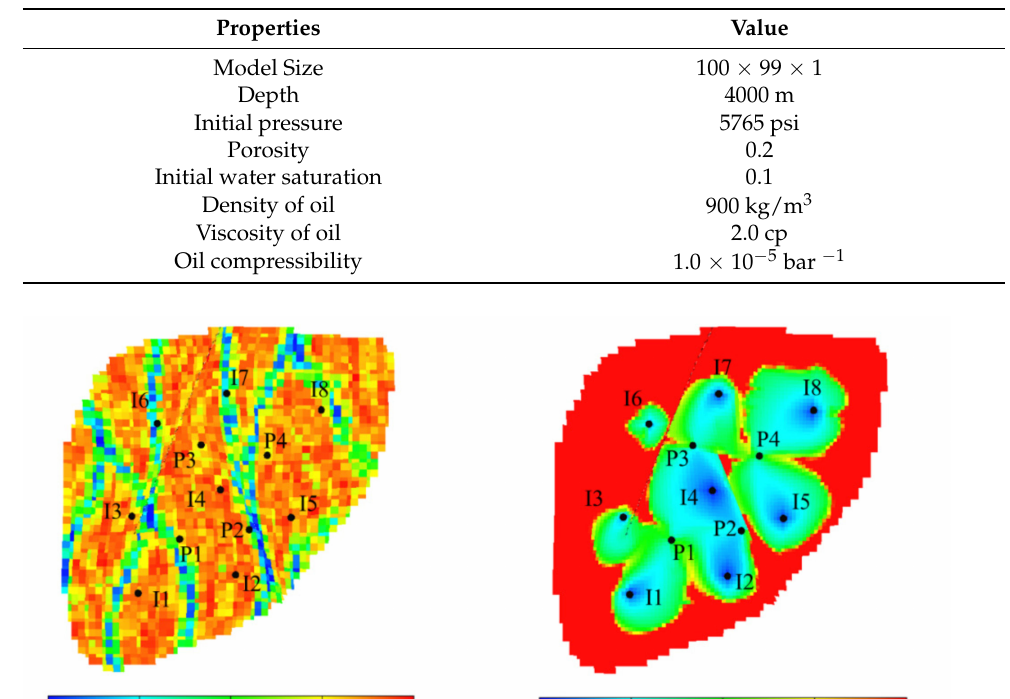
Table 5. Properties of Egg reservoir model.